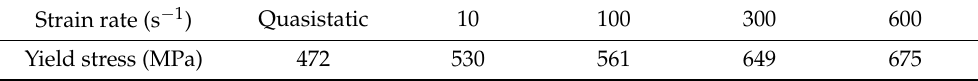
Figure 7. Tensile test results of the material. Table 1. Mechanical properties obtained by quasistatic tensile test. Table 2. Comparison of quasistatic and dynamic yield stress under various strain